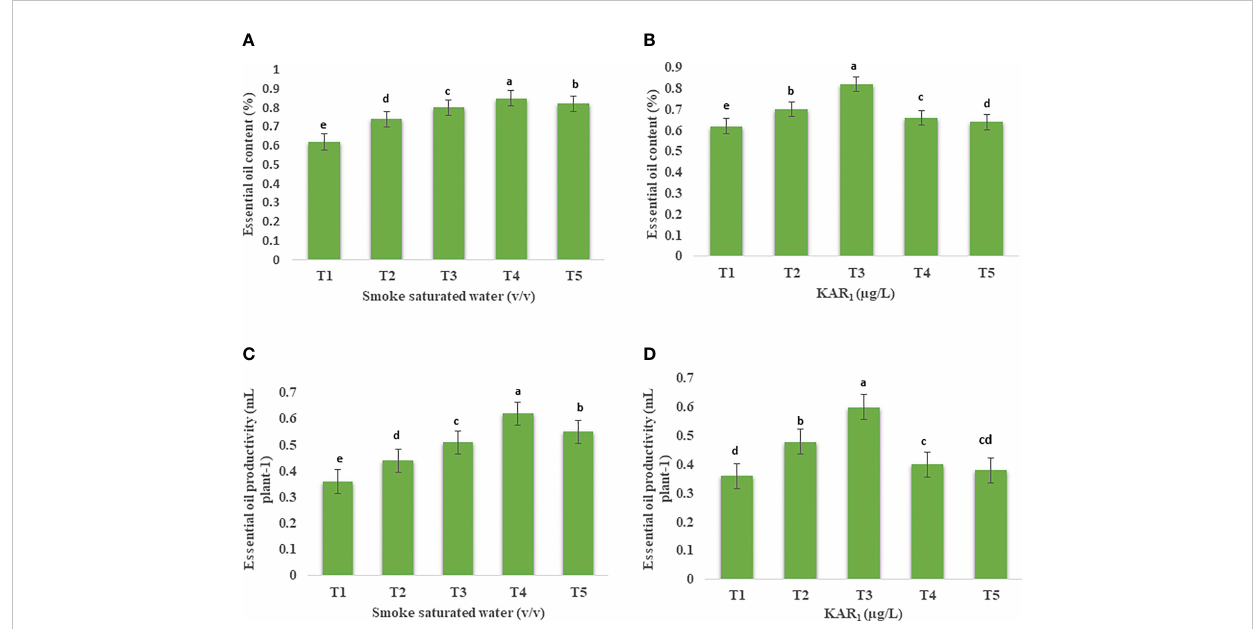
FIGURE 6 Effect of foliar application with (A) smoke-saturated water (32.25 µg/L, 64.5 µg/L, 1: 500 v/vand 258 µg/L) and KAR 1 (0.150 µg/L, 1.501 µg/L, 15.013 µg/L and 150.13 µg/L) on essential oil content (%) (A, B) and essential oil productivity (mL plant -1 ) (C, D) of Mentha arvensis L. Lowercase letters depicts the Duncan. Data are presented as treatments mean ± SE (n = 5). Data followed by the same letters are not signi fi cantly different by Duncan multiple range test at p ≤